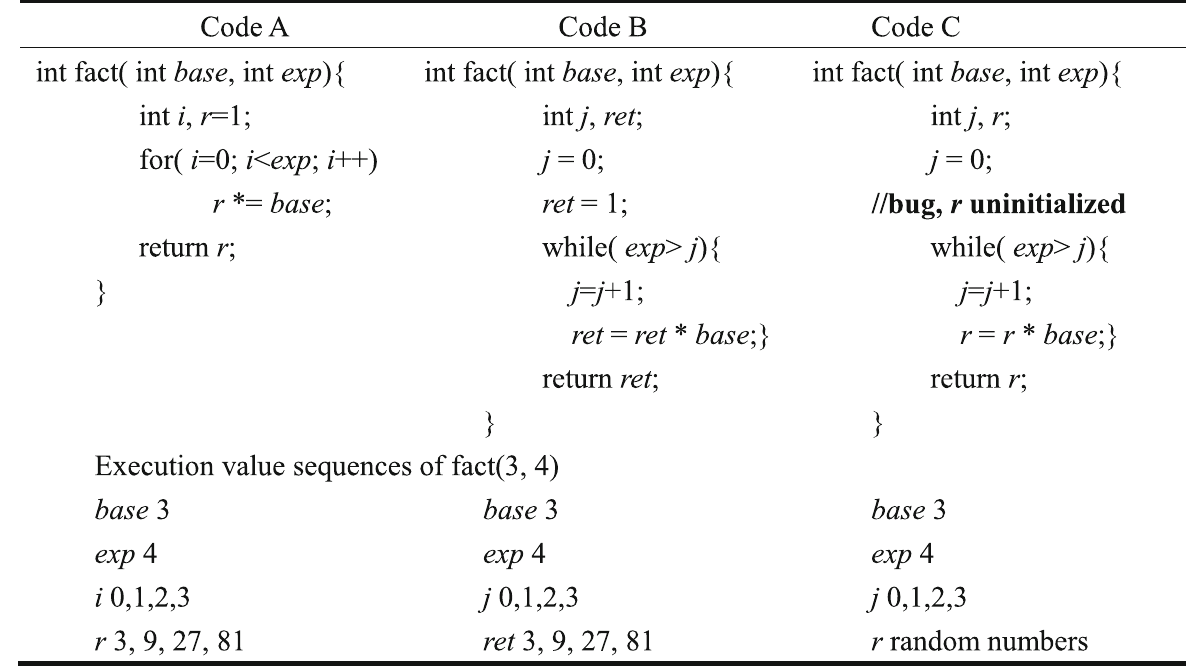
Fig. 1 Example programs with code